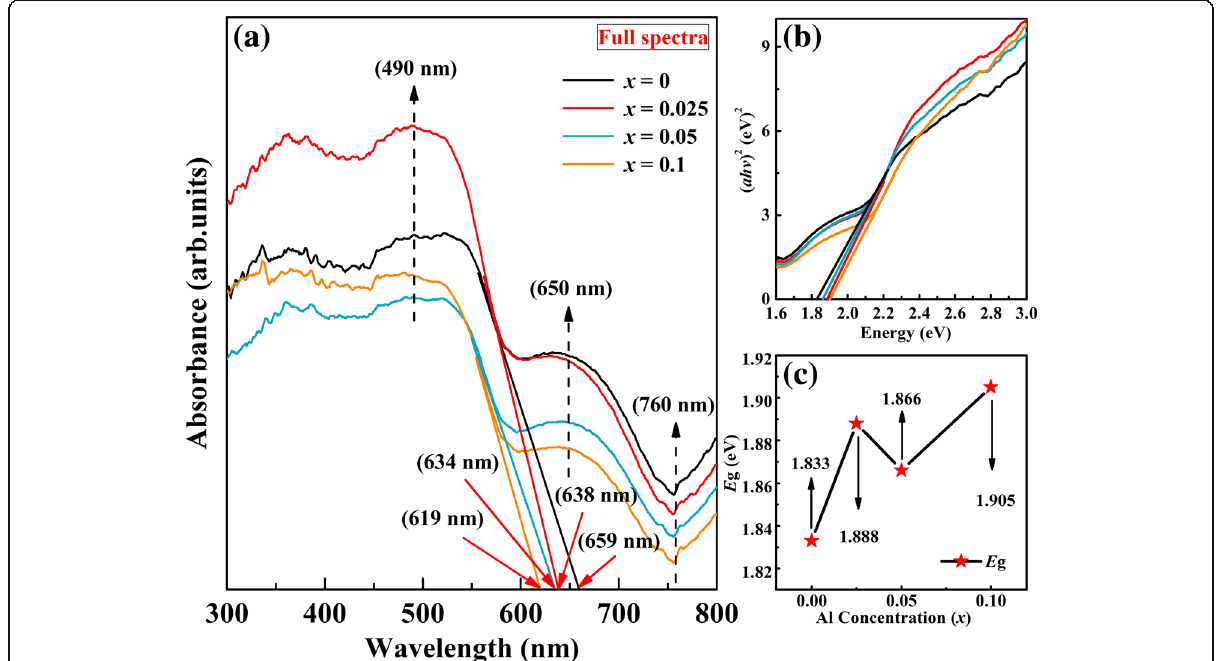
Fig. 7 a UV-Vis absorption spectrum of BFA x O (0 ≤ x ≤ 0.1). b Plots of ( ah ν ) 2 vs. photon energy. c E g values as a function of Al